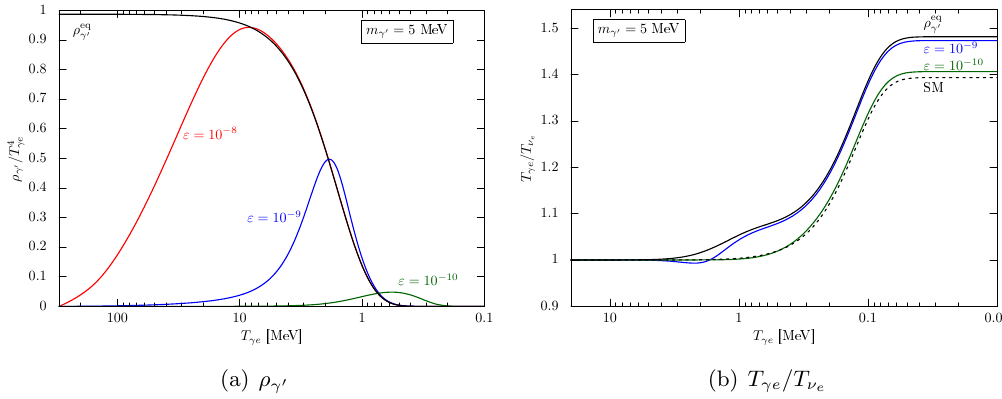
(b) T (cid:13)e =T (cid:23) e (cid:13) 0 and (b): the ratio = 5 MeV and 0